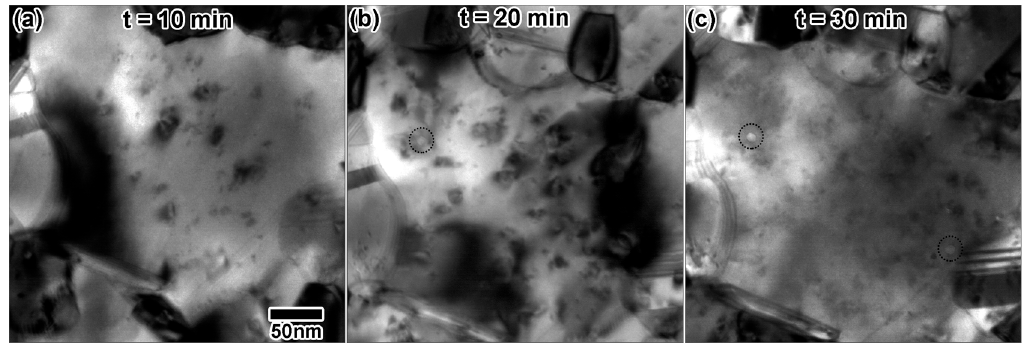
Figure 10. In situ TEM images from triple ion beam irradiation with 10 keV He, 5 keV D and 1.7 MeV Au shown after ( a ) 10 min, ( b ) 20 min and ( c ) 30 min. Dashed circles indicate possible cavity formation. At 30 min, irradiation doses were as follows: 7.11 × 10 16 D/cm 2 + 3.55 × 10 16 He/cm 2 + 1.88 × 10 11 Au/cm 2 , 2.1 He + 0.88 D + 0.005 Au dpa and 7.37 at % He + 15.49 at % D. All TEM images were taken at the same magnification.